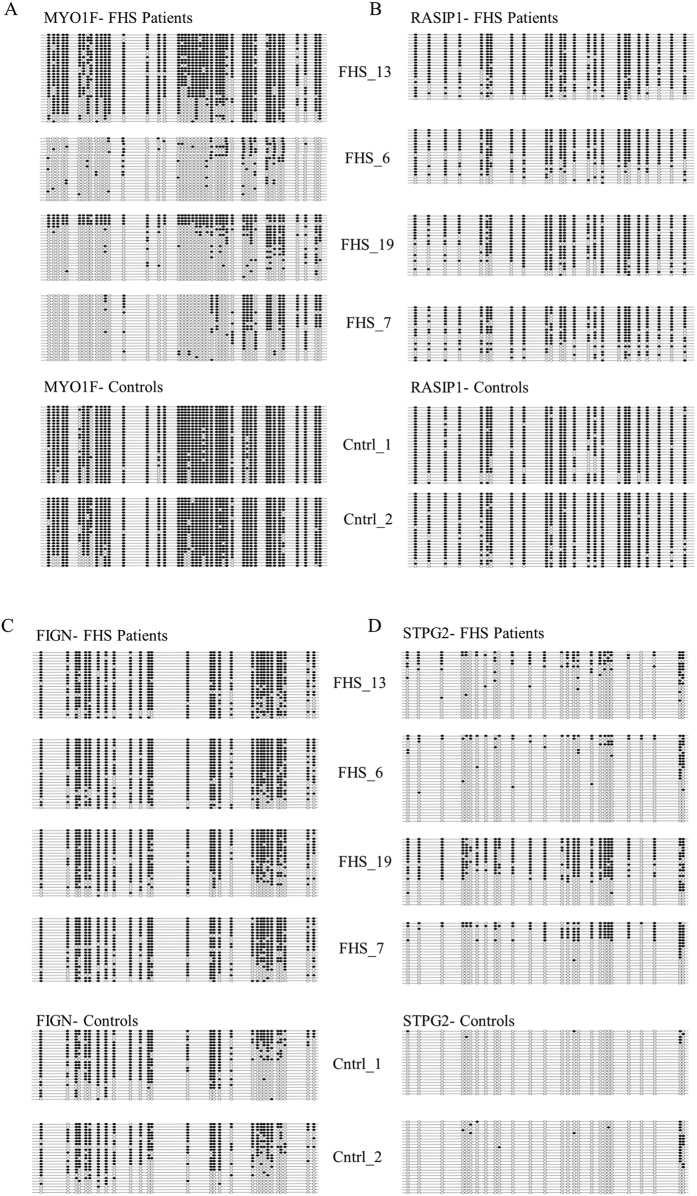
Methylation string diagrams of significantly altered regions in FHS individuals compared to controls.String diagrams indicating methylation status across regions with significantly altered methylation in FHS: hypermethylated regions (a) MYO1F and (b) RASIP1, and hypomethylated regions (c) FIGN and (d) STPG2; for four FHS individuals (top) and two gender matched control samples (bottom). Each dot on the string indicates a CpG sequence, and potential site for methylation. Black dots indicate the CpG is methylated. Open dots indicate the CpG is un-methylated.